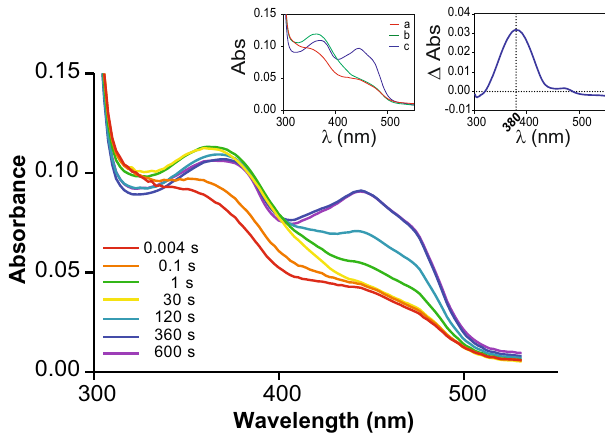
Fig. 5 | Oxygenating intermediate formation for tAncFMO1-4. Spectra were timely recorded to monitor the reaction of reduced tAncFMO1 – 4 with molecular oxygen in a stopped- fl ow apparatus. Representative ones are shown ( n = 3 independent experiments). The upper left inset shows the deconvoluted spectra fi tted into a two-step process a ! k 1 b ! k 2 c with k 1 = 3.2 ± 0.11s − 1 and k 2 = 0.0065± 0.0001 s − 1 . The upper right inset shows the change in absorbance between species a (E-FADH 2 ) and b (E-FADOO(H)). Source data are provided as a Source Data fi